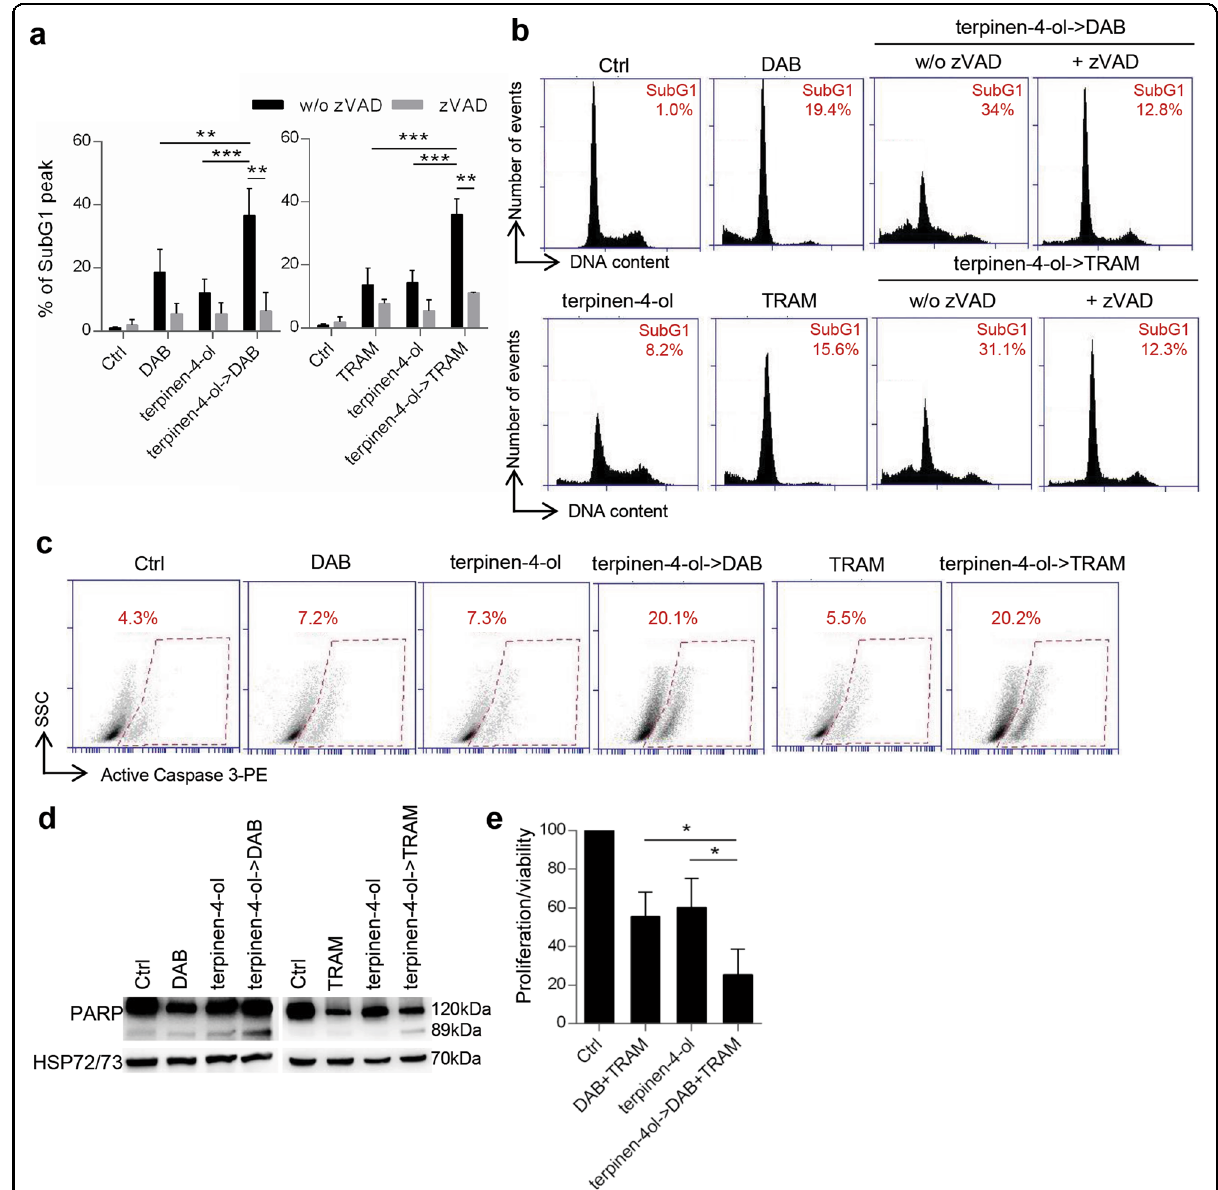
Fig. 6 Terpinen-4-ol induces apoptosis in combination with targeted therapy. a Quanti fi cation and b representative images relative of subG1 peak by propidium iodide staining of M14 cells treated with 48 h dabrafenib (DAB, 0.2 μ M) or trametinib (TRAM, 10 nM), 24 h terpinen-4-ol (7.4 μ g/ml) alone or in combination (24 h terpinen-4ol->48 h DAB/TRAM), in the presence or absence of zVAD (50 μ M). c Flow cytometric analysis of active caspase 3-PE staining in cells treated with 48 h dabrafenib (0.2 μ M) or trametinib (10 nM), 24 h terpinen-4-ol (7.4 μ g/ml) alone or in combination (24 h terpinen-4ol->48 h DAB/TRAM). d Western blot analysis of PARP cleavage in M14 cells treated as reported in c . HSP72/73 was used as loading and transferring control. Western blot representative of two blots is shown. e MTT assay of M14 cells treated with dabrafenib (0.001 μ M) + trametinib (0.1nM) for 48 h, terpinen-4-ol (7.4 μ g/ml) for 24 h alone or 24 h terpinen-4-ol followed by 48 h DAB + TRAM (terpinen-4-ol->DAB + TRAM). The results are reported as “ cell proliferation-viability of treated cells/cell proliferation-viability of control cells × 100 ” . a , e The results represent the average±standard deviation of three independent experiments. Experiments with zVAD were repeated twice. p -values were calculated between control (Ctrl) and treated cells, cells treated in combination and cells treated with single drugs, or between cells treated or not treated with zVAD. * p < 0.05; ** p < 0.01, *** p < 0.001 after applying Student ’ s t